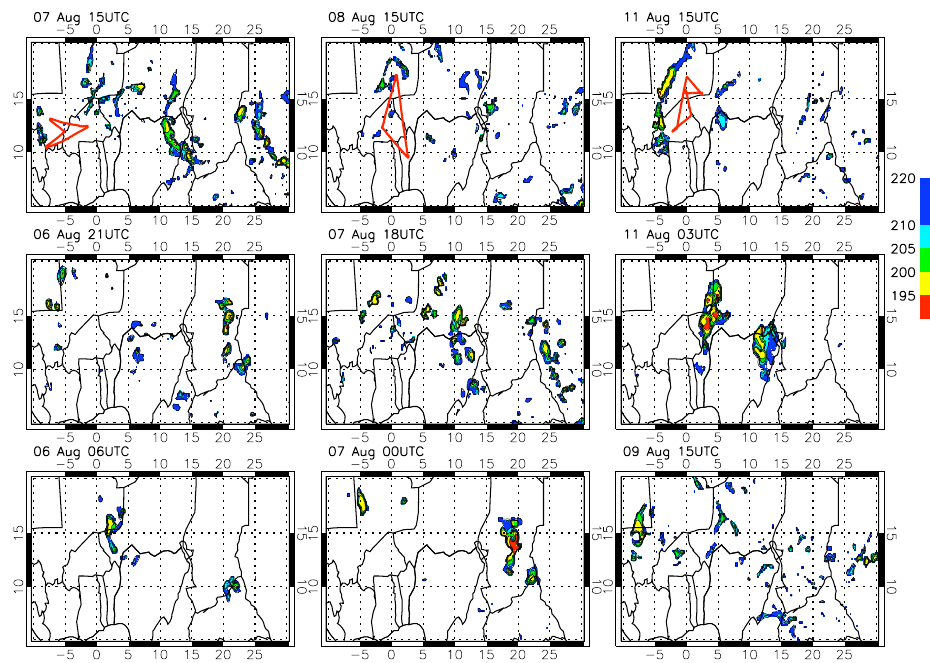
Fig. 5. As Fig. 1 but for the BOLAM model